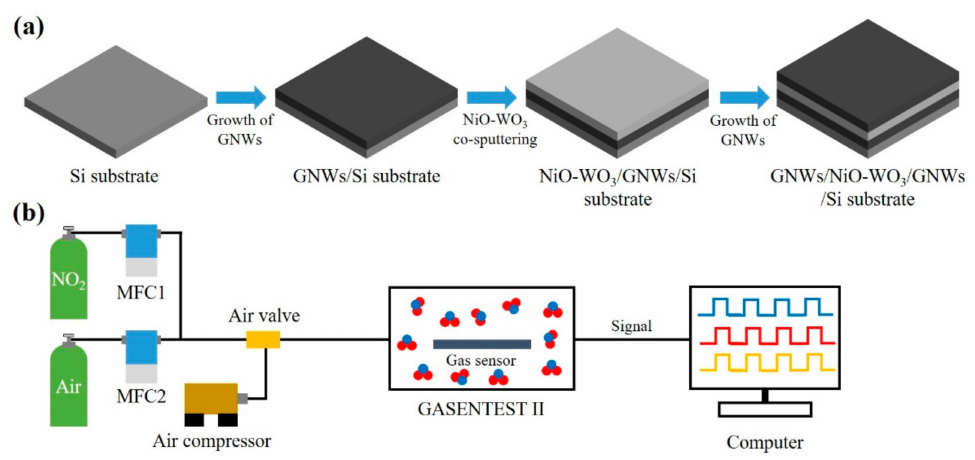
Figure 1. Schematic illustration of GNWs/NiO-WO 3 /GNWs heterostructure-based NO 2 gas sensor. ( a ) Fabrication process of GNWs/NiO-WO 3 /GNWs heterostructure-based NO 2 gas sensor using PECVD and sputtering system. ( b ) Measurement of sensing performance under exposure to NO 2